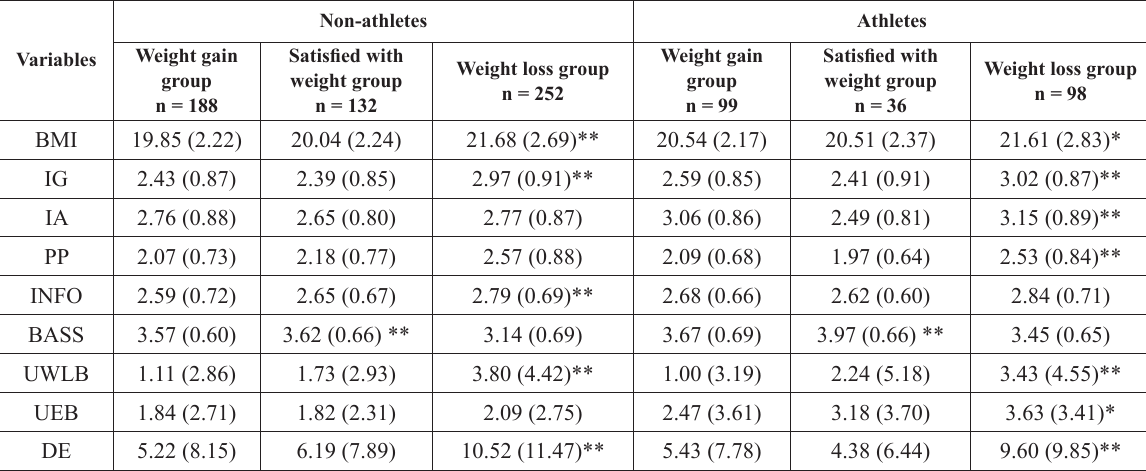
Table 2. Means and standard deviations for all variables for desired weight groups in athletes and non- athletes Variables